Question: What type of chart is this?
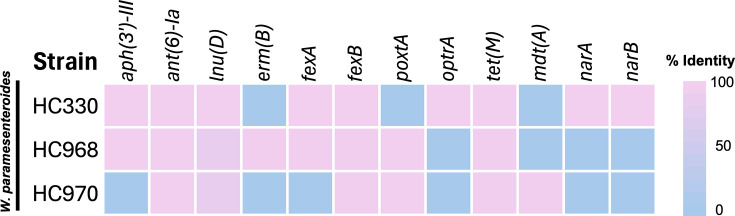
Answer: heatmap